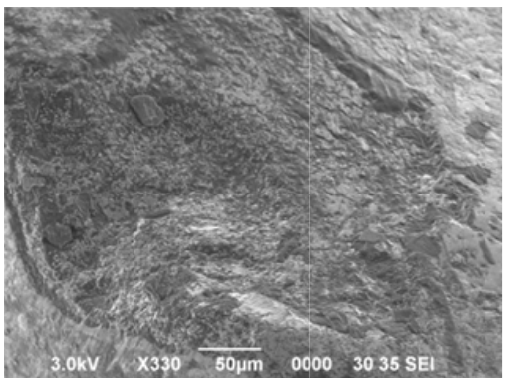
Figure 11. Crater wear at V c D 60 m = min, f D 0:09 mm = rev, and d D 0:3 mm.